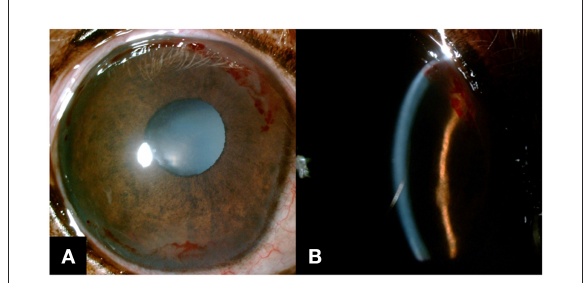
FIGURE2 Slit-lamp biomicroscope images were obtained a week after the bandage contact lens wear. (A) ICH in an annular pattern was noted as OD. (B) Subepithelial hemorrhage was noticed on the slit beam